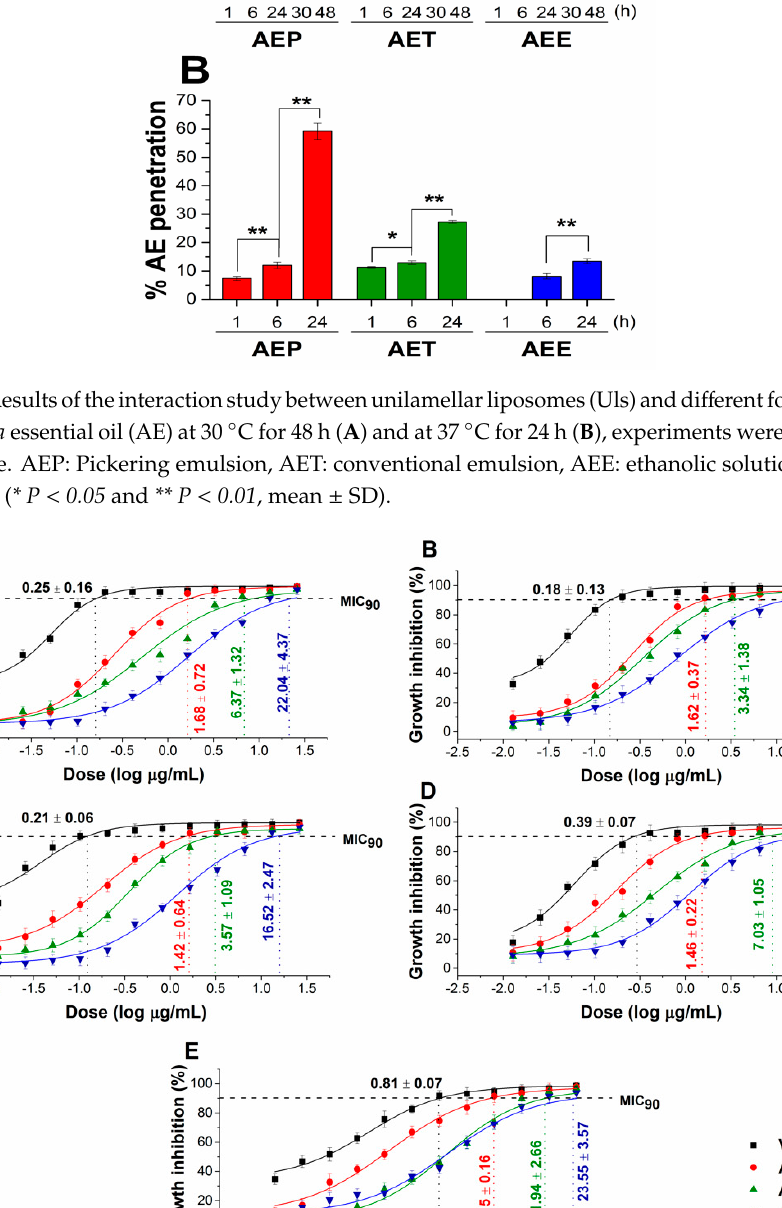
Figure 4. Minimum inhibitory concentration (MIC 90 ) of AEP, AET, AEE, and caspofungin (CAS) in µg/mL on S. pombe ( A ), C. albicans ( B ), C. tropicalis ( C ), C. dubliniensis ( D ) and C. krusei ( E ). Six independent experiments each with three technical replicates were performed (mean ± SD).